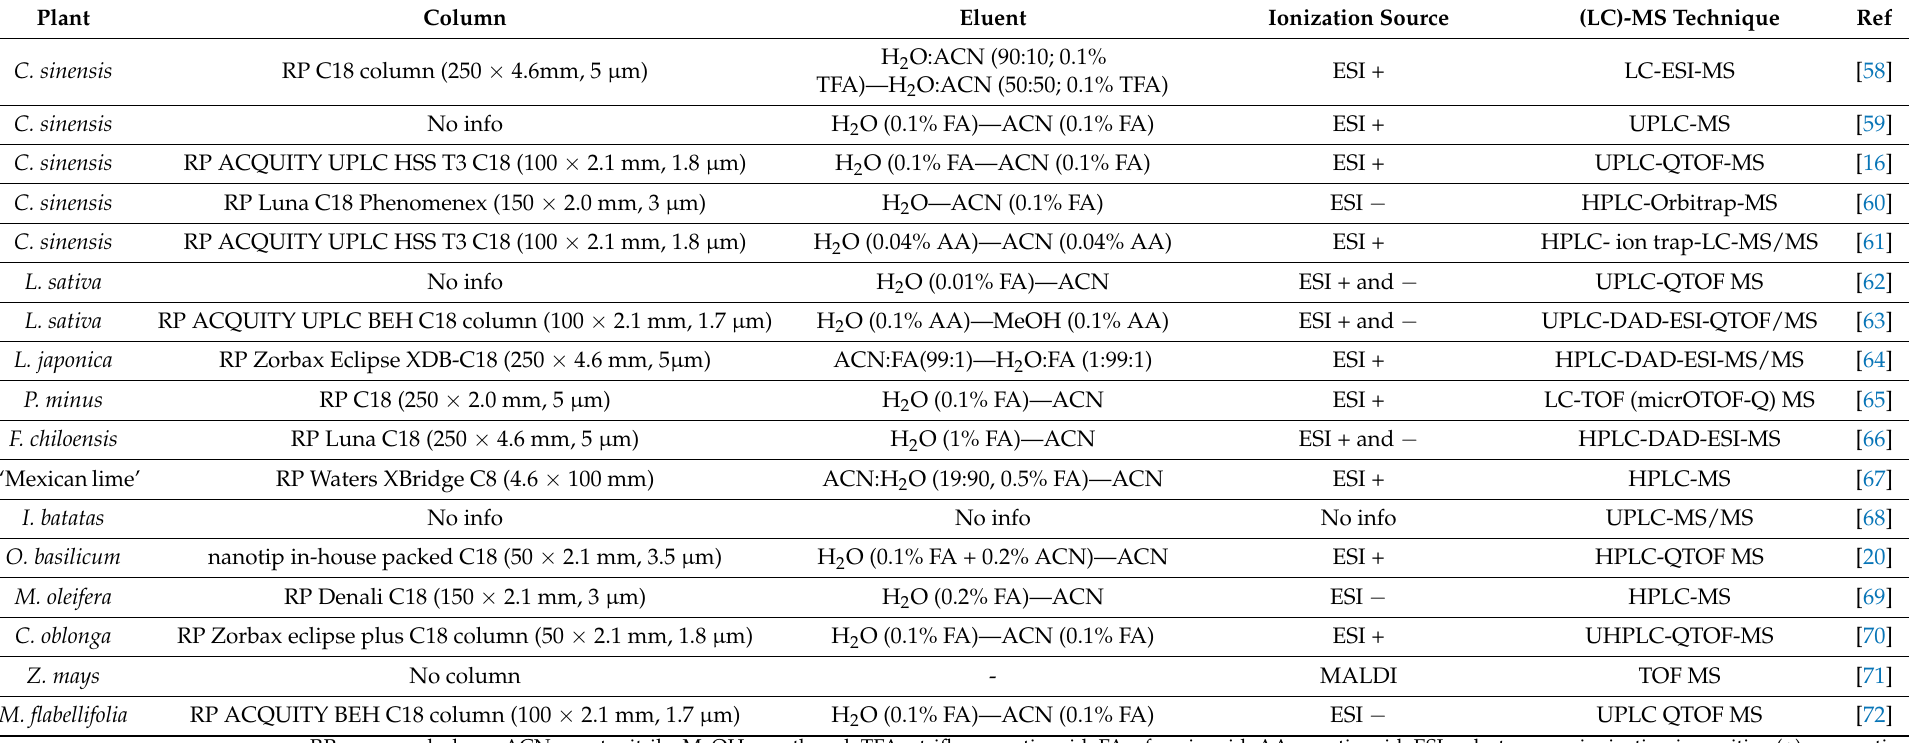
Table 2. Anthocyanins—chromatographic and mass spectrometry